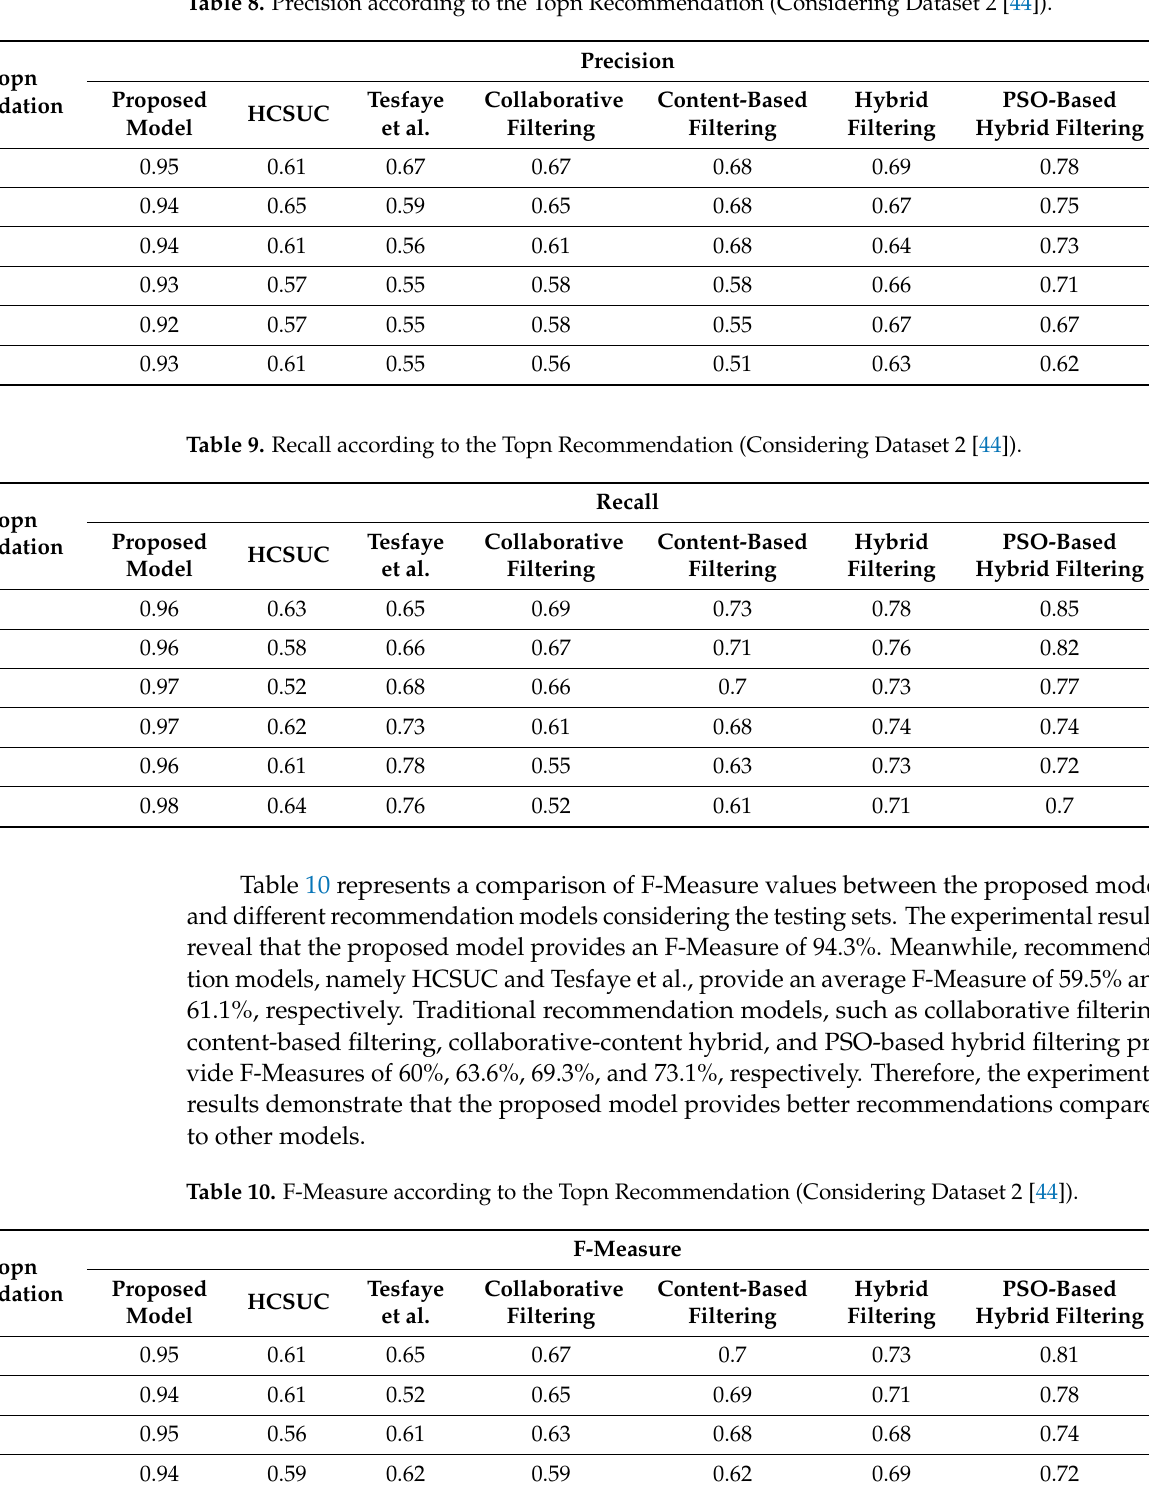
Table 8. Precision according to the Topn Recommendation (Considering Dataset 2 [44]).